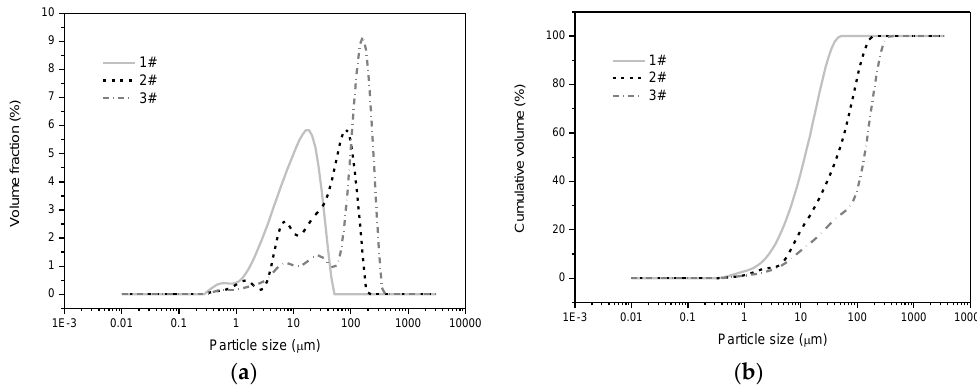
Figure 1. The coal particle size distribution results: ( a ) volume fraction; ( b ) cumulative volume.